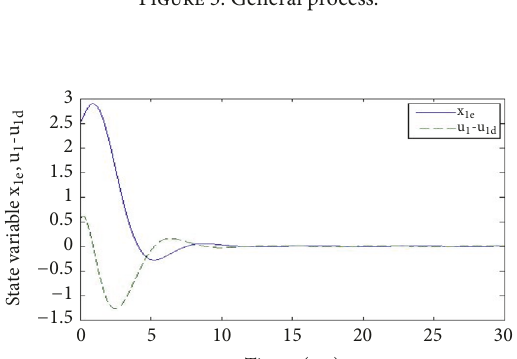
Figure 2: Target tracking process for the second step .